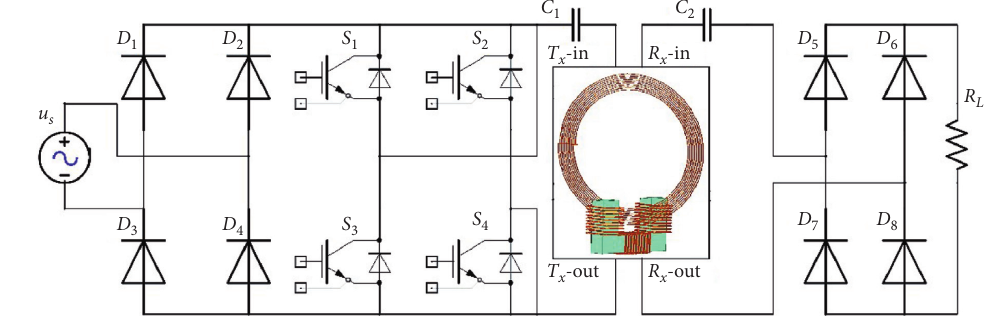
Figure 7: Joint simulation model.